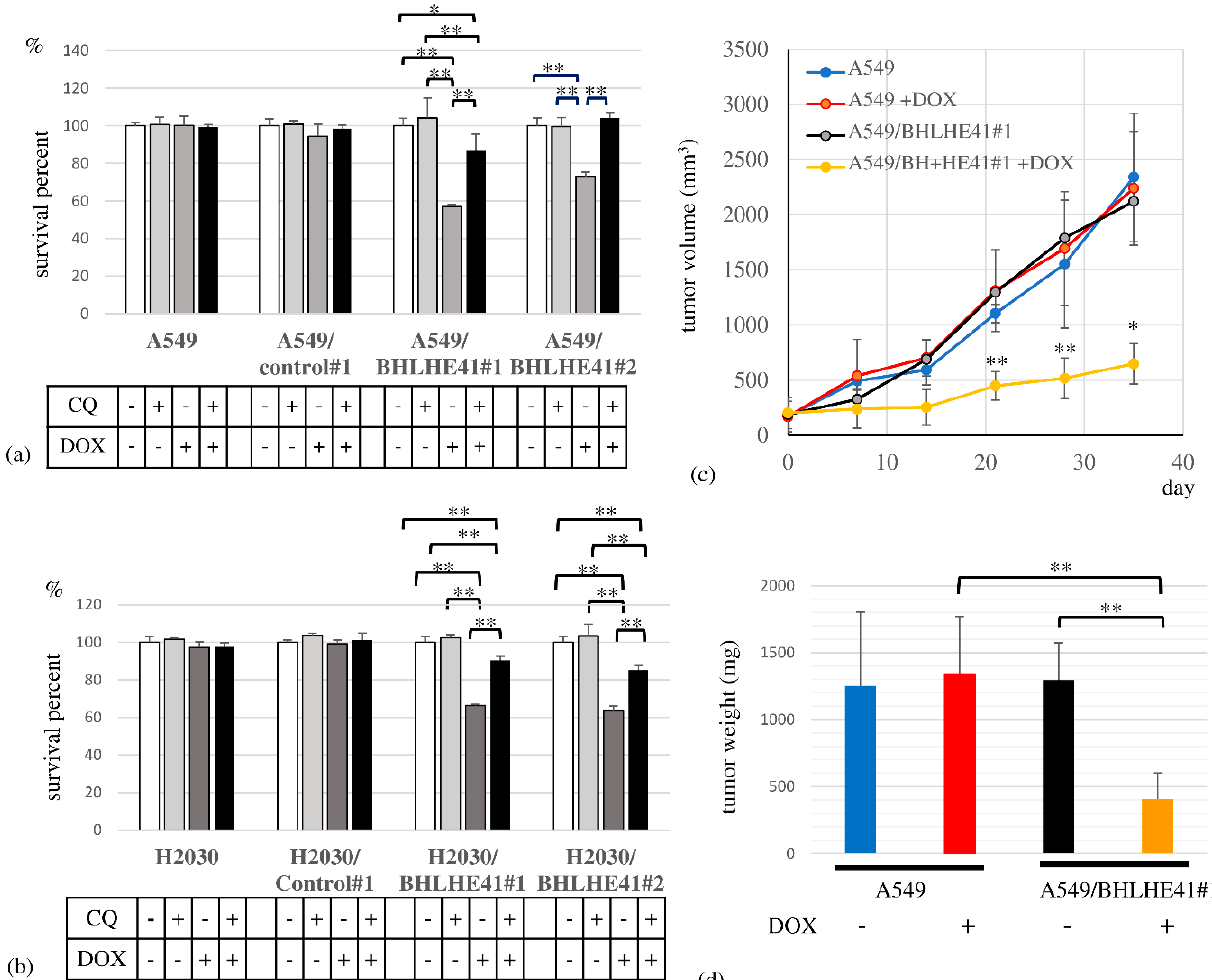
Figure 4. Cell survival assay and xenograft model experiment. Cell survival assay in the presence and absence of CQ (10 μ M) or DOX for A549- and A549-derived cells (0.5 μ g/mL), and for H2030- and H2030-derived cells (2 μ g/mL) for 3 days. ( a ) A549 cells, A549/control#1, A549/BHLHE41#1 and A549/BHLHE41#2 cells; ( b ) H2030; H2030/control#1; H2030/BHLHE41#1 and H2030/BHLHE41#2 cells. ( c ) In the xenograft model, the growth of tumors of A549 and A549/BHLHE41#1 cells with and without DOX (2 mg/mL)-containing water. Statistical significance of the difference between A549/BHLHE41#1 tumors with and without DOX water-based feeding is indicated as * p < 0.05 at the 35th day and ** p < 0.01 at the 21st and 28th day. ( d ) Weight of isolated tumors of A549 and A549/BHLHE41#1 cells with and without feeding of DOX-containing water.